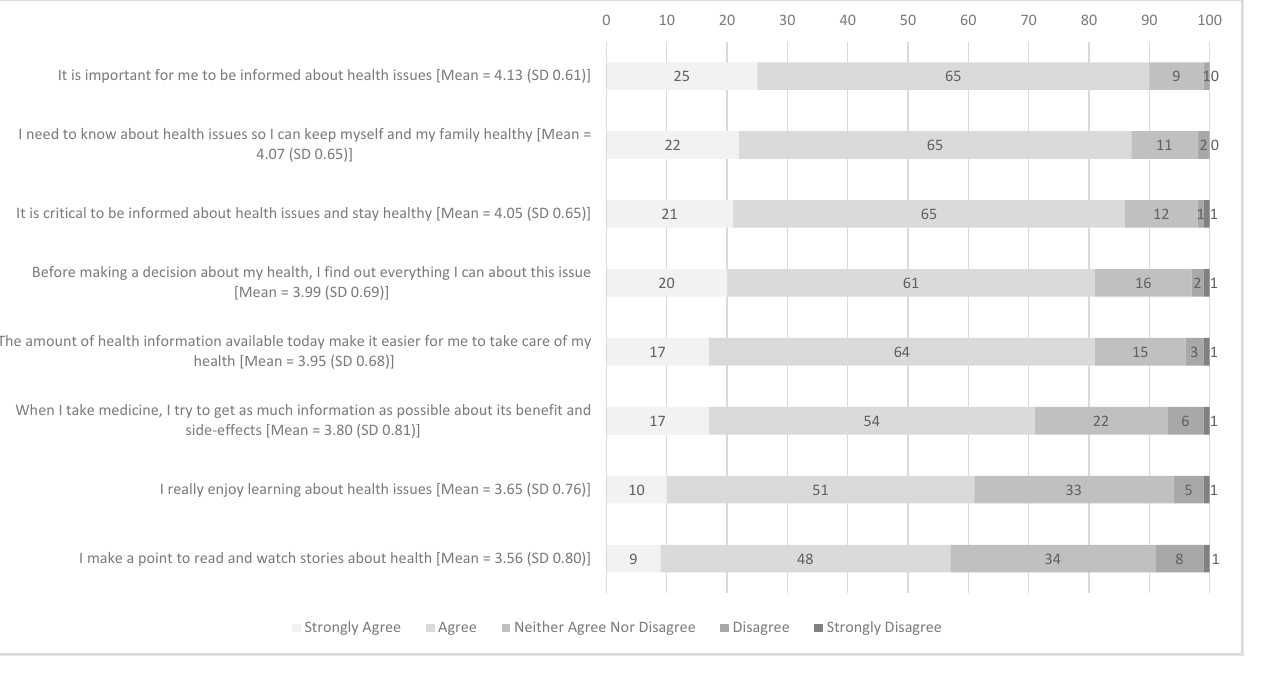
Figure 1. Proportion of responses (%) from 2004 respondents on statements assessing health information orientation.